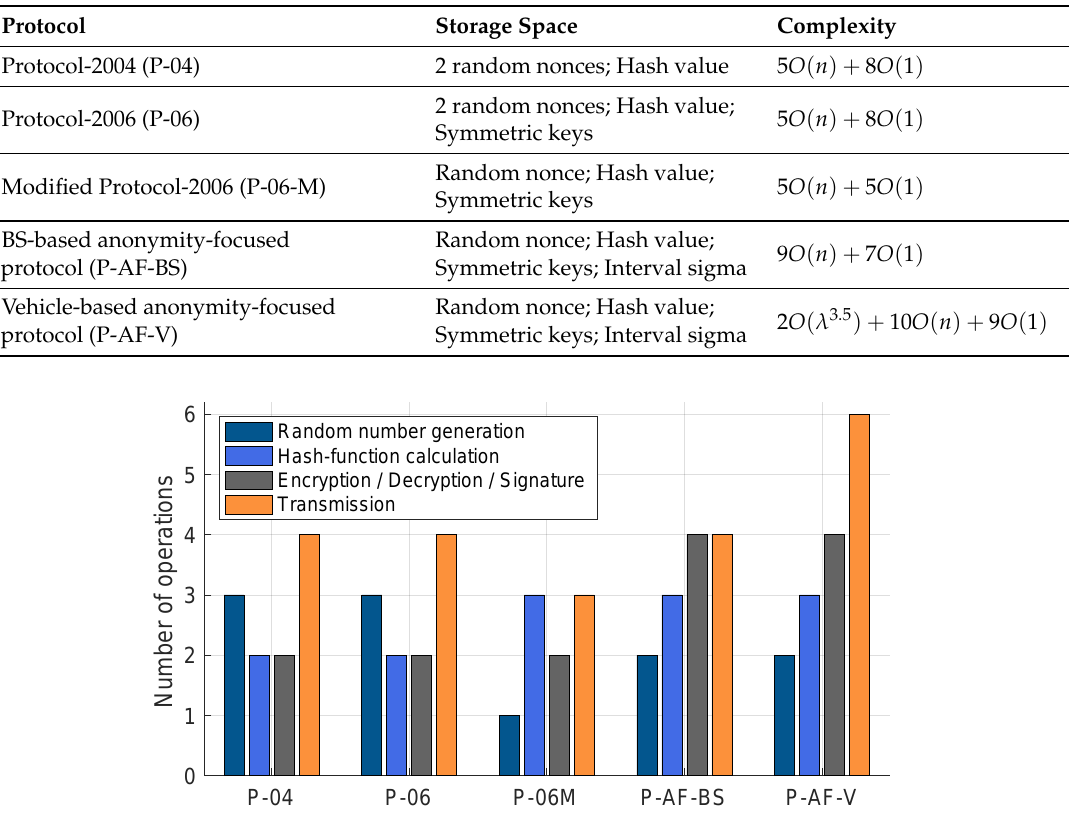
Figure 9. Number of different operations required per